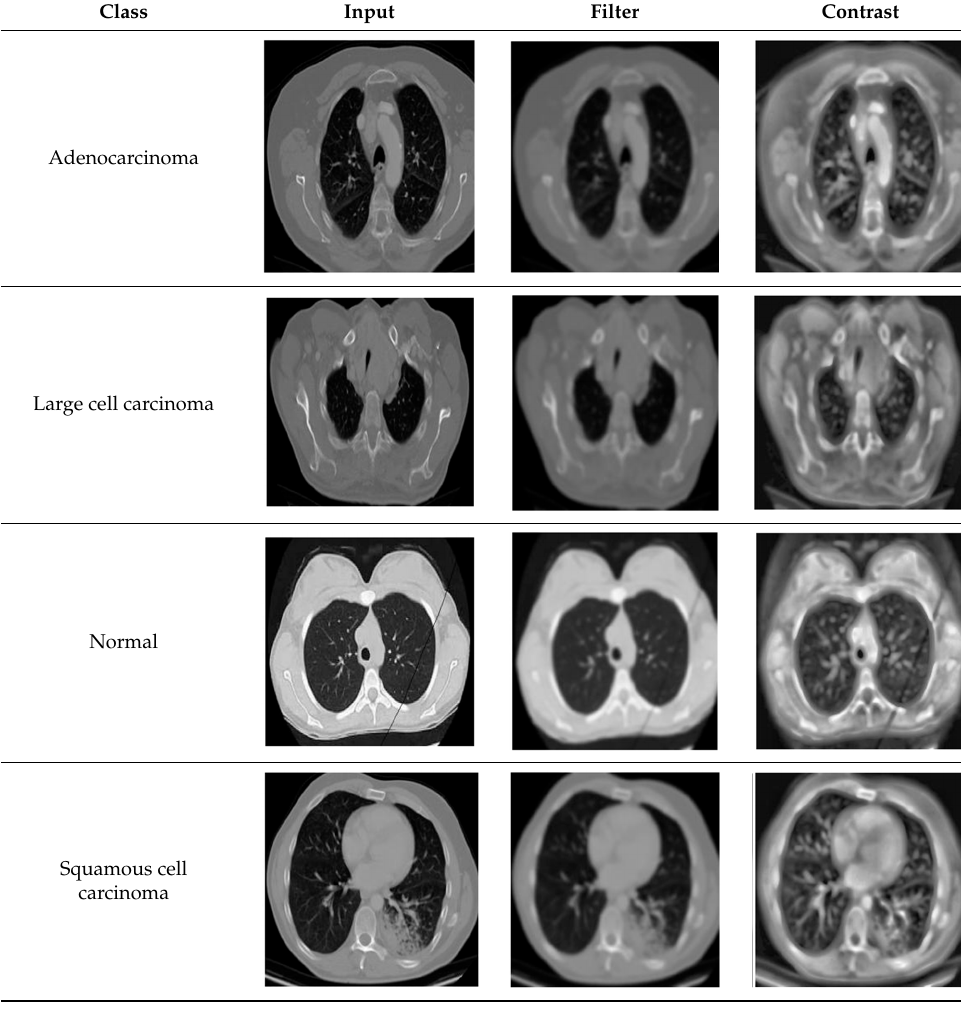
Table 4. Filtered image’, ‘Contrast enhanced image’.